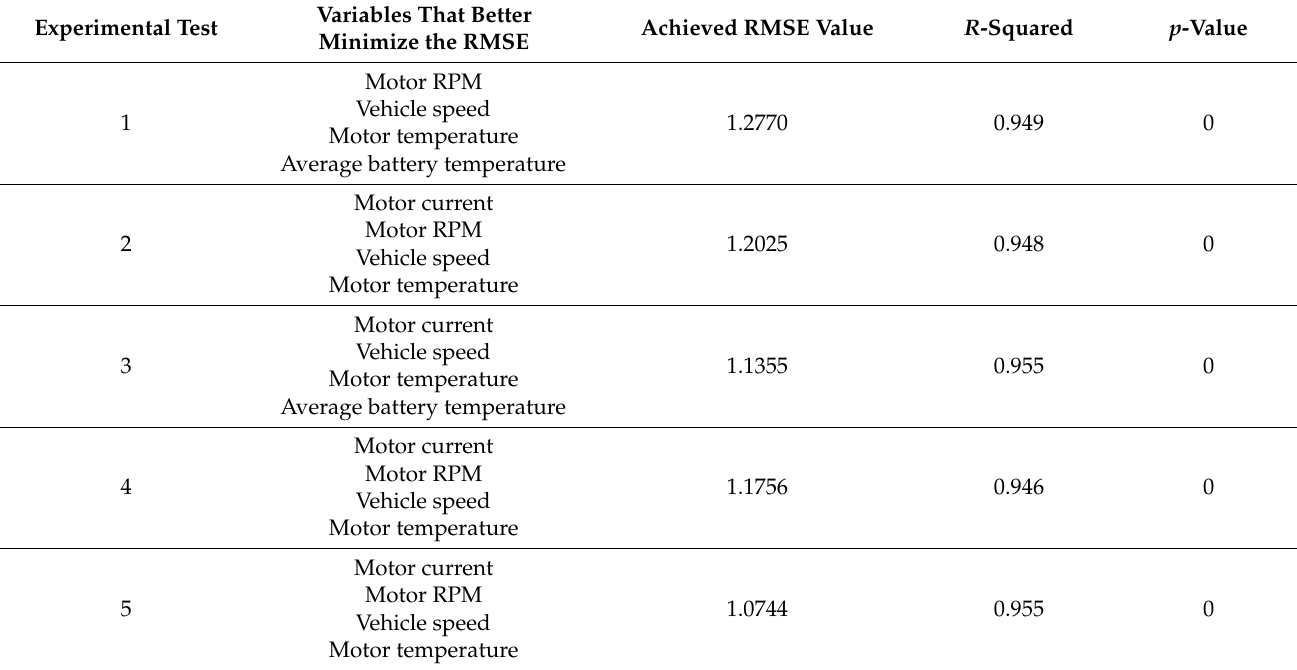
Table 4. Variables that best minimize the RMSE for the third transmission